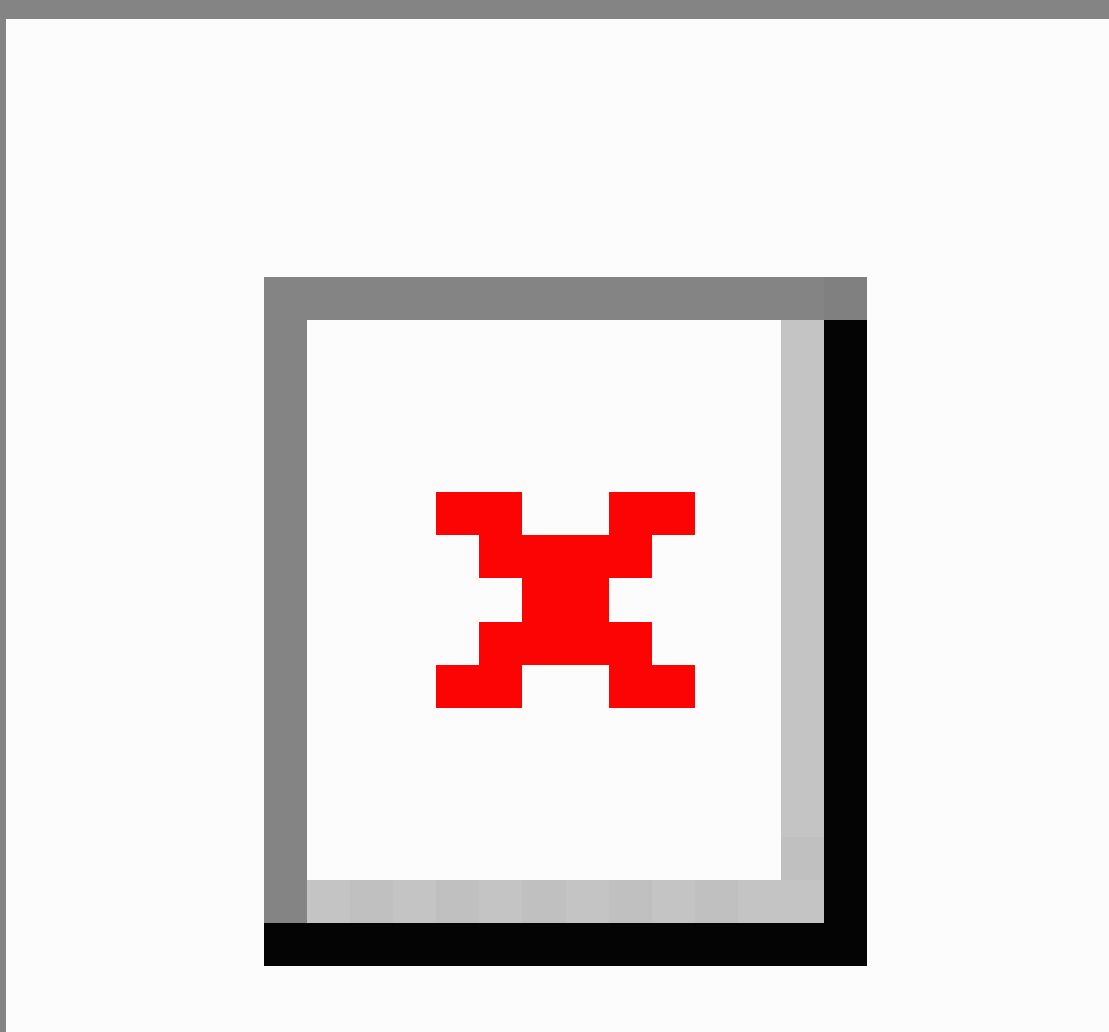
Figure 5. Comparison of physical activity and resting heart rate data recorded for two subjects during the 12-week PPAP application feasibility study. Completed TRIMP values for S1 demonstrated strong adherence to the recommended physical activity prescription (A). Observed (filled circles) and 10-day moving average (solid line) HRrest for S1 demonstrated a downward trend during the 12-week intervention (B). S2 progressed into week 4 of the intervention, but he did not achieve 70% of the recommended weekly physical activity duration for the subsequent weeks (C). Despite poor adherence to the program, the intervention progressed in week 12 to initiate an EFT. Email reminders were sent at the start of week 5 and 8, and S2 had